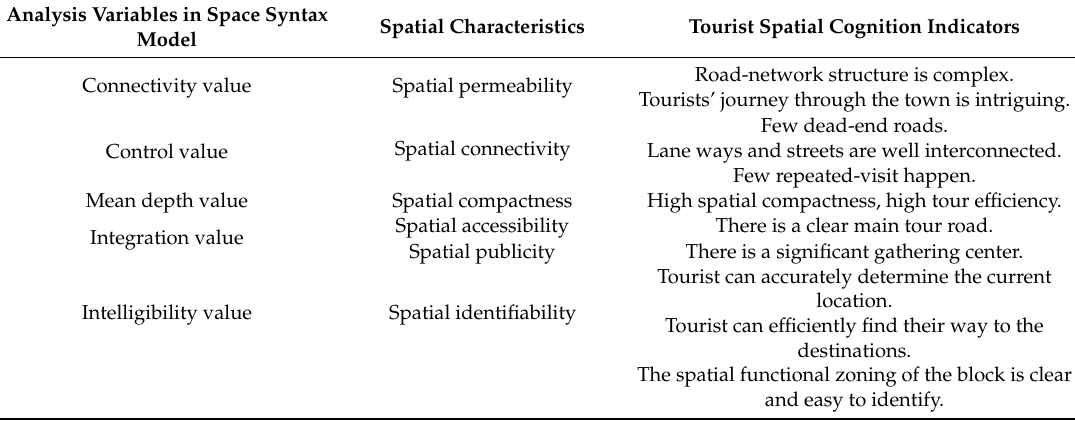
Table 1. Analysis variables in space syntax model and tourist spatial cognition